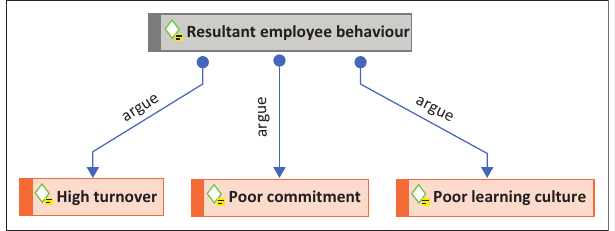
FIGURE 3: Resultant employee behaviour theme and supporting codes or